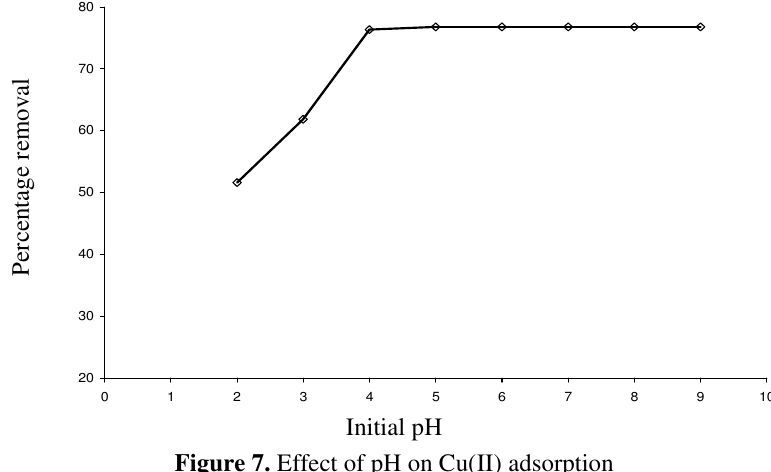
Figure 7. Effect of pH on Cu(II)